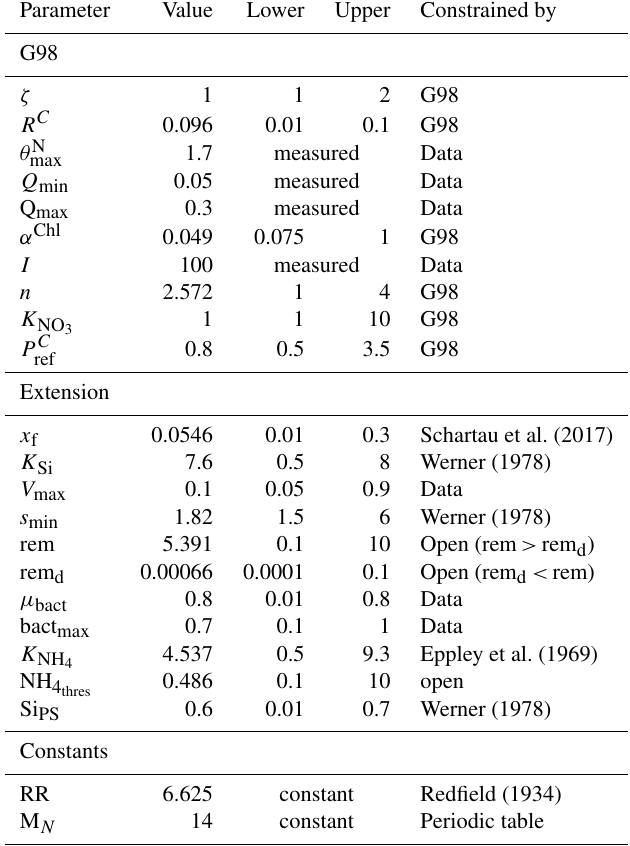
Table A3. Parameters and constants of the original G98 model and the EXT model with initial values used in the model and the lower and upper value constraints used for model fitting, unless the parameter was already defined by the data (measured). The constraints are either based on G98 fits to other diatom species, to present experimental data, or to typical values found in the